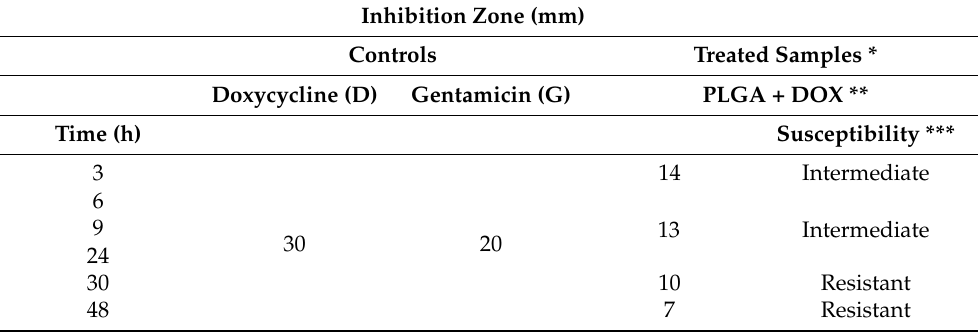
Table 3. Evaluation of the inhibition zone diameter obtained in microbiological assays.